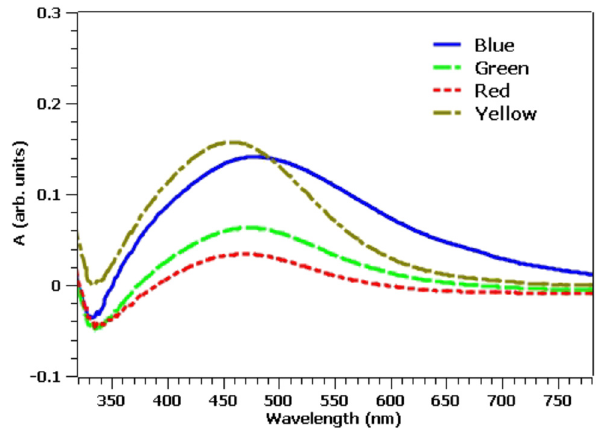
Figure 7: UV - Vis spectra of the sample exposed to di ff